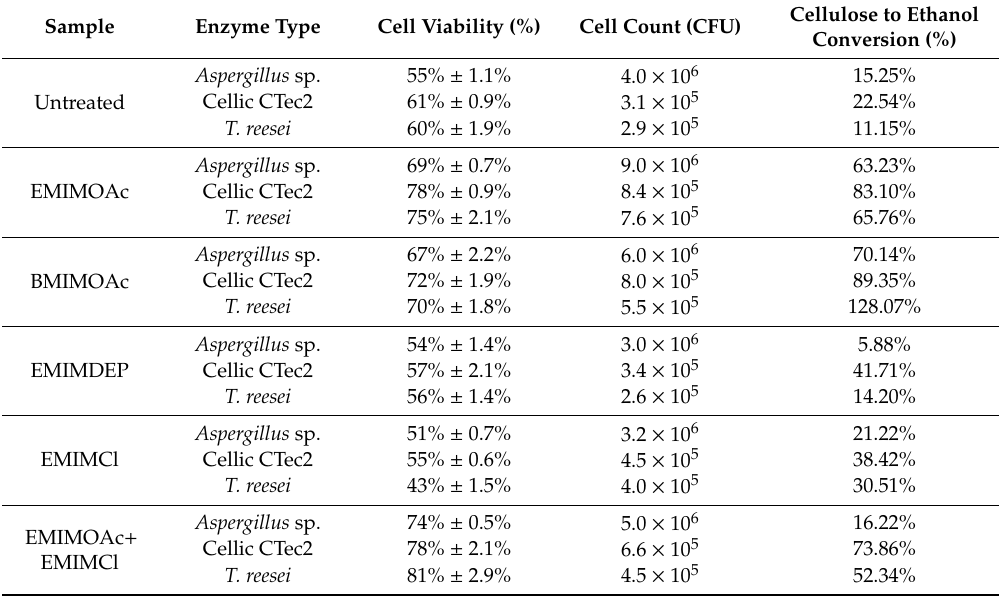
Table 4. Counts and viability of yeast cells after alcoholic fermentation of buckwheat straw samples before and after treatment with ionic liquids and conversion of cellulose to ethanol for individual